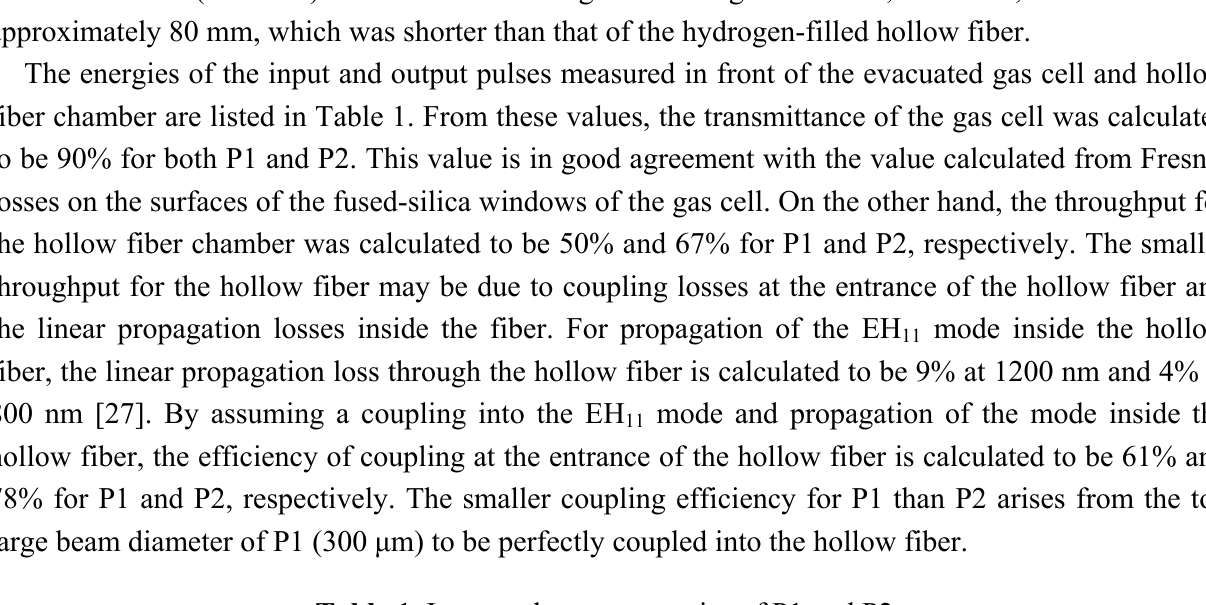
Table 1. Input and output energies of P1 and